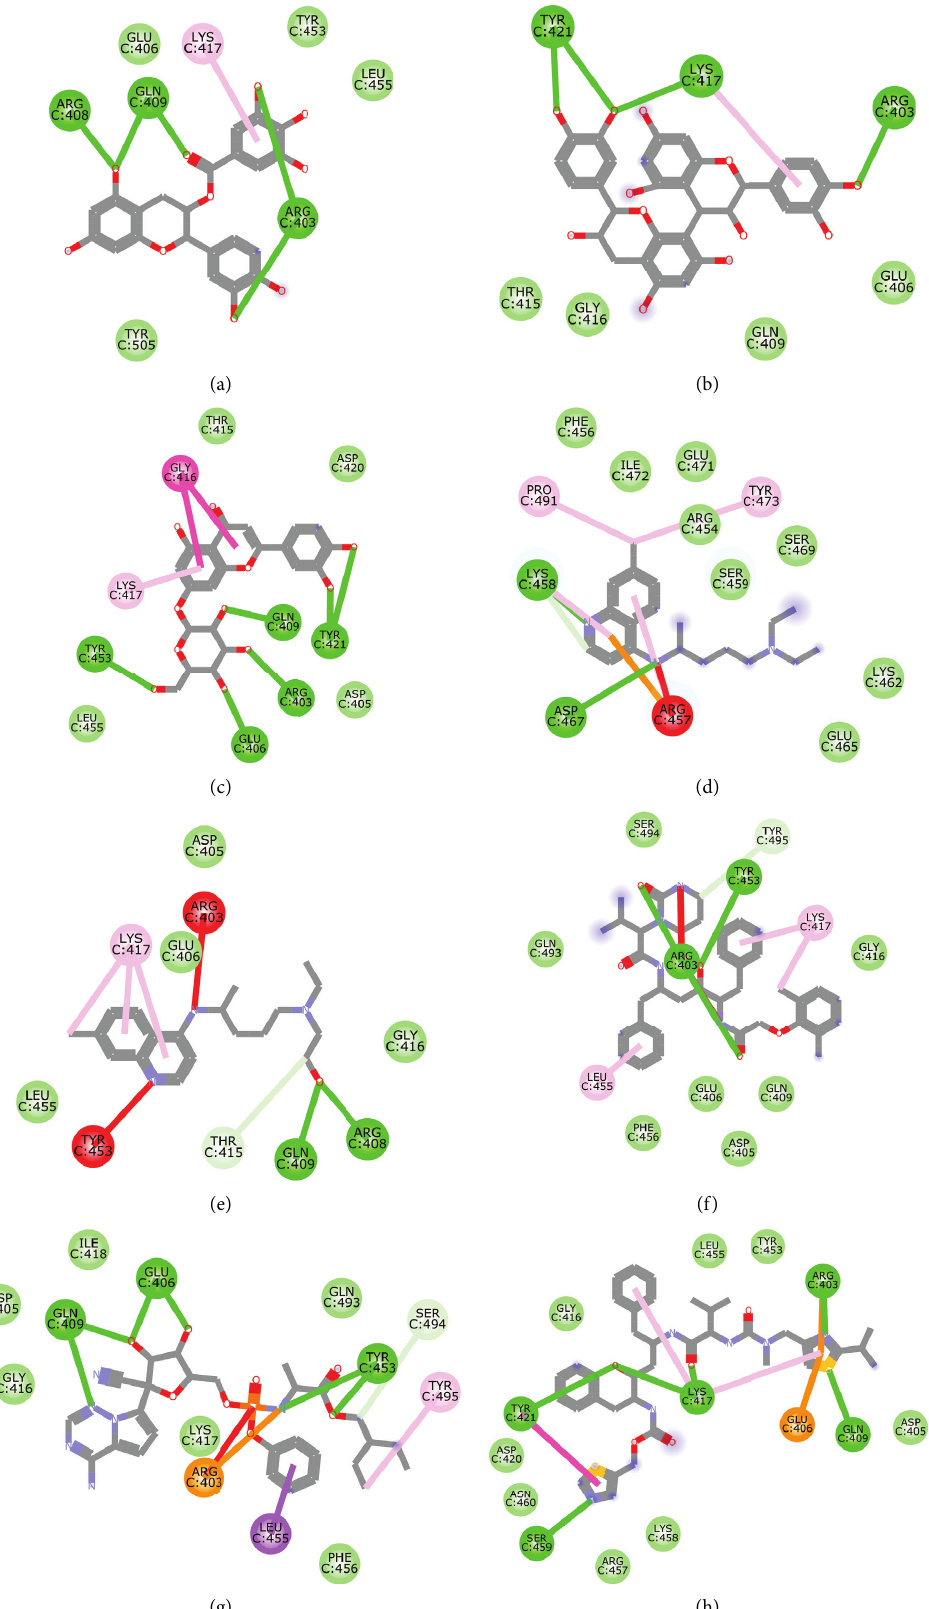
Figure 11: 2D representation of (a) 3-galloylcatechin, (b) proanthocyanidin B1, (c) luteolin 7-galactoside, (d) chloroquine, (e) hydroxy- chloroquine, (f) lopinavir, (g) remdesivir, and (h) ritonavir in the binding pocket of S-RBD. Hydrogen, unfavourable, and π bonds are depicted as green, red, and any other coloured (purple, magenta, orange, and pink) lines, while Van der Waal interactions appear as light green